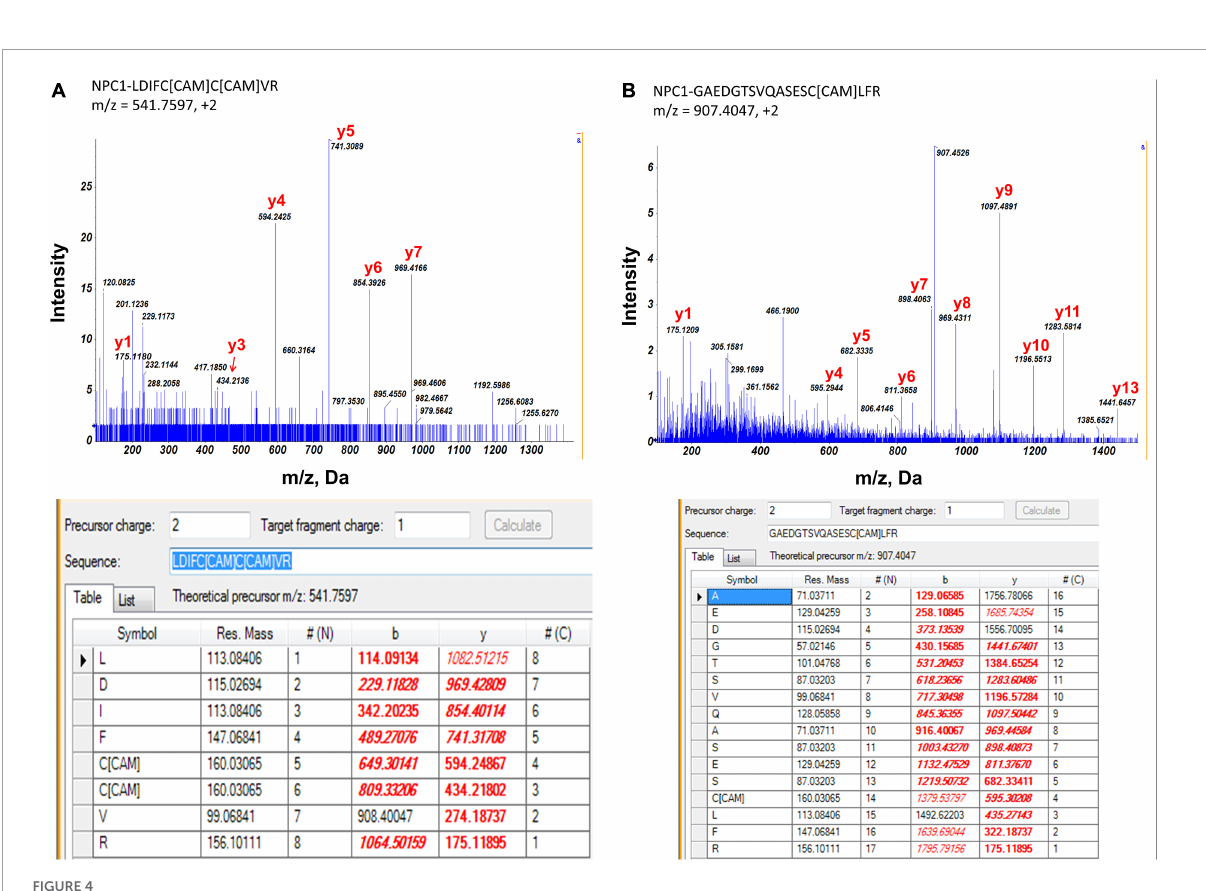
FIGURE4 MS/MS spectrum of two peptide fragments originated from NPC1 protein. *Carboxyamidomethylcysteine. (A) Peptide fragment LDIFC*C*VR (m/z = 541.8, charge = 2+). It showed evidence of palmitoylation at Cys799 and Cys800 of NPC1 protein. (B) Peptide fragment GAEDTSVQASESC*LFR (m/z = 907.4, charge = 2+). It showed evidence of palmitoylation at Cys816 of NPC1 protein. Experimental data matched with theoretical values were highlighted in